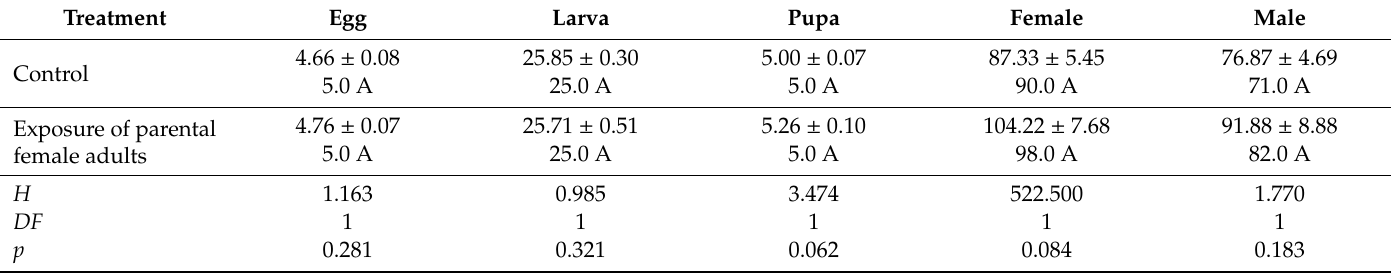
Table 2. Duration of developmental stages and adult longevity in days (mean ± SE, median) of Tribolium castaneum when female parental adults were exposed to chlorfenapyr.